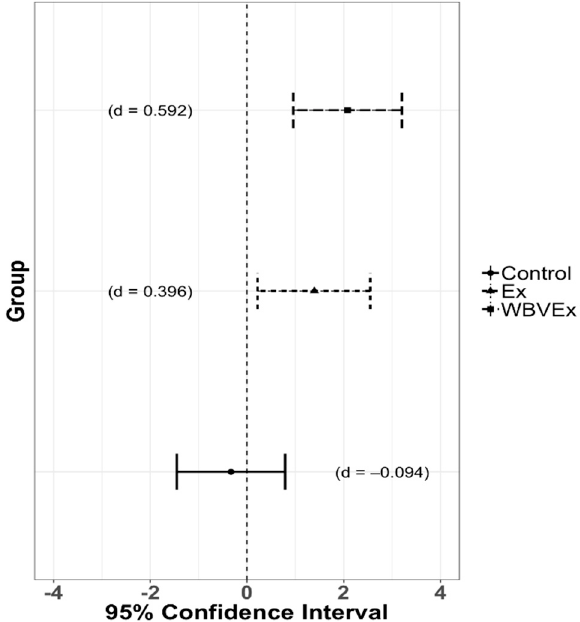
Figure 3. Algometer forest plot immediately following the foot march.